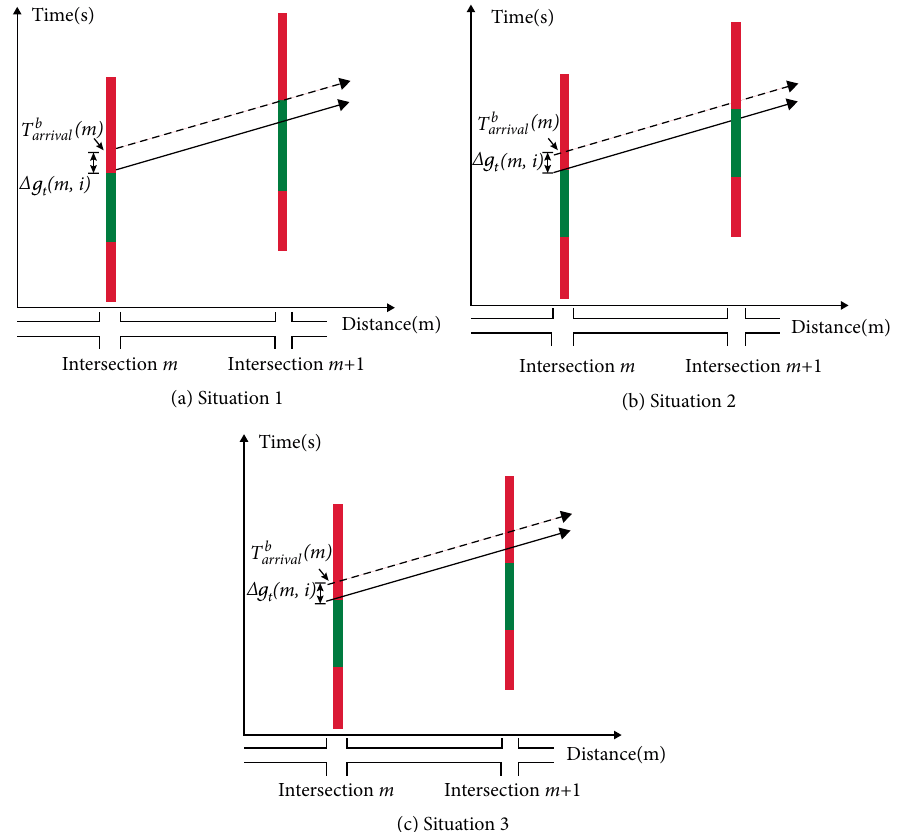
Figure 2: Implementation of the green light extension